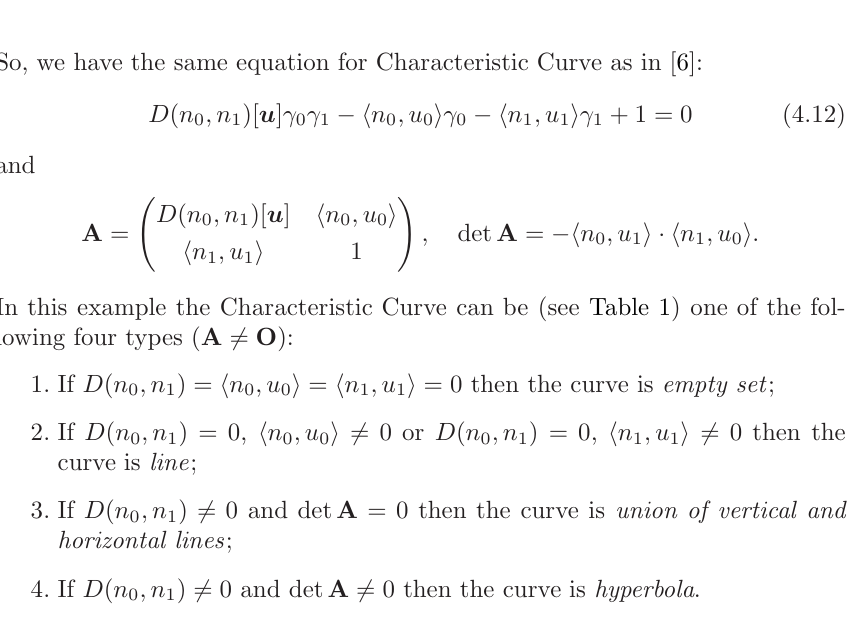
Figure 2. Characteristic Curve for Bitsadze-Samarskii type nonlocal boundary conditions in the case det A =